Question: In one sentence, what is this figure communicating?
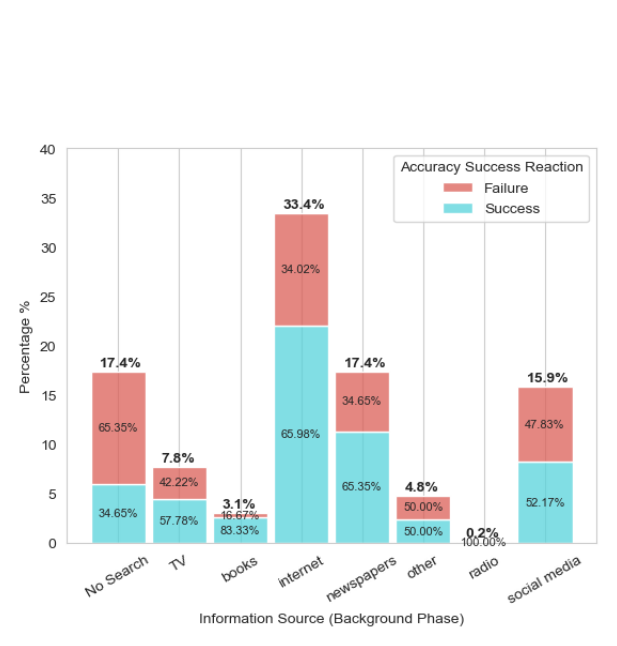
Answer: Information source at Background phase and Ac- curacy Success distribution at the Reaction phase. Percent- ages on top of the bars represent the distribution of the in- formation sources among participants at the Reaction phase. Percentages within the bars represent the success rates for different information sources.